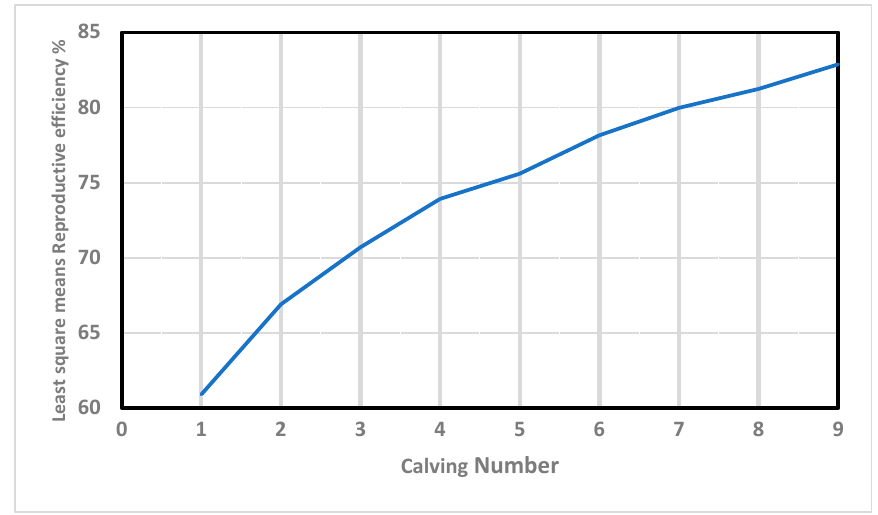
Figure 1. Effects of calving number on reproductive efficiency in Retinta breed.